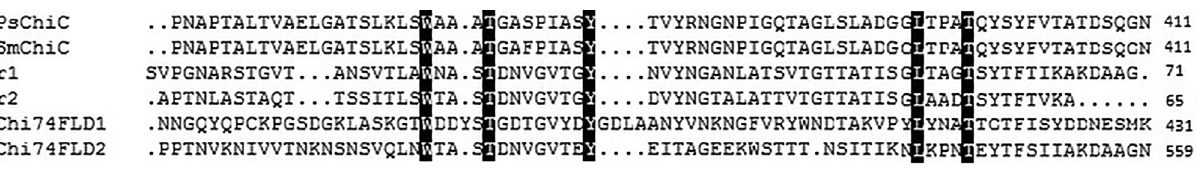
Figure 4 - Alignment of the Fn3-like domain of PsChiC with those of other bacterial enzymes. The sequences of PsChiC Fn3-like are aligned with those of Serratia marcescens chitinase C1 (CAF74787), Bacillus circulans chitinase A1 (r1 and r2, AAA81528) and Bacillus thuringiensis serovar kenyae ChiA74 (Chi74FLD1 and Chi74FLD2, AAL17867). Black shading indicates identical amino acid residues.